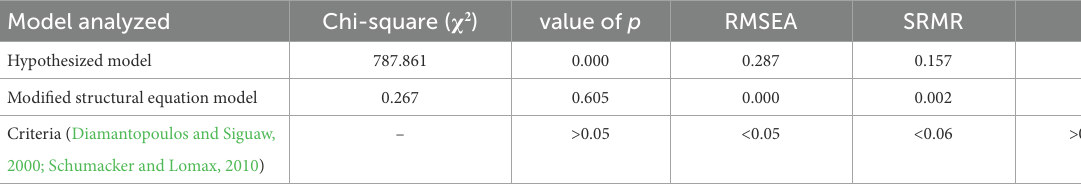
TABLE 6 Regression weights, errors, and p -values. Relationships